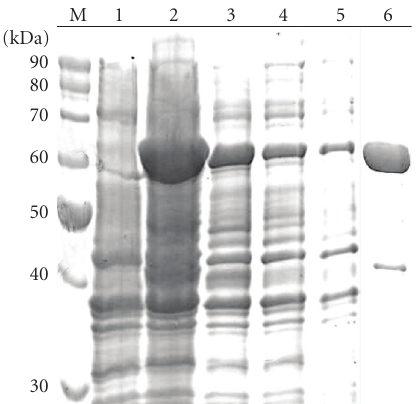
Figure 2: Recombinant enzyme purification. Fractions collected before and after Ni-NTA chromatography were visualized on 12% SDS-PAGE. Lane M, protein BenchMarker (Invitrogen); Lane 1, crude extract of uninduced E. coli cells; Lane 2, crude cell extract after induction for 3 hours; Lane 3, cellular extract (input); Lane 4, flow-through; Lane 5, washing step (20mM imidazole); Lane 6, purified urate oxidase ( ∼ 30.5 μ g) after elution with 200 mM